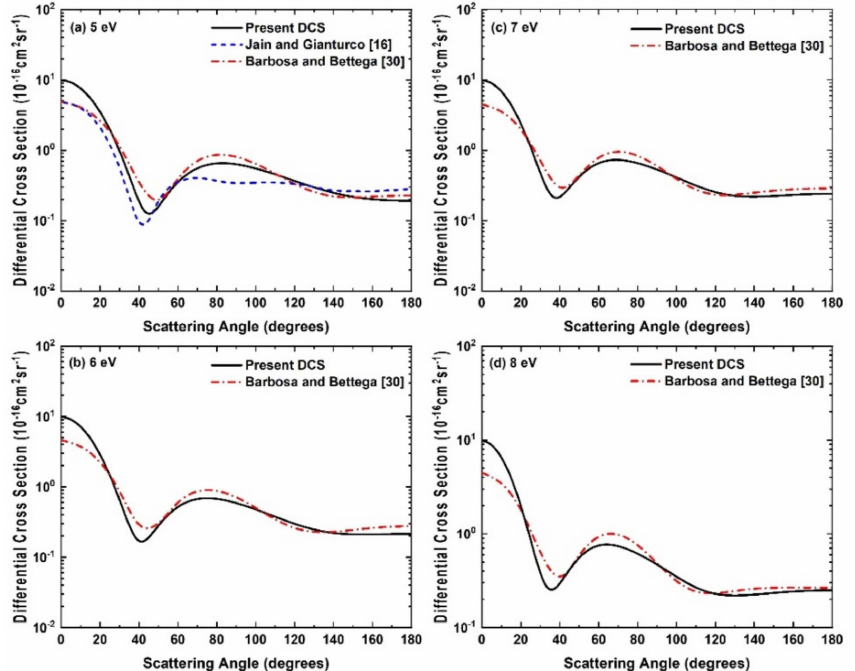
Figure 7. Differential cross sections for positron-SiH 4 elastic scattering at incident positron energies ( a ) 5 eV, ( b ) 6 eV, ( c ) 7 eV and ( d ) 8 eV. Solid line, present DCS; dashed line, Jain and Gianturco [16]; dashed dot line, Barbosa and Bettega [30].